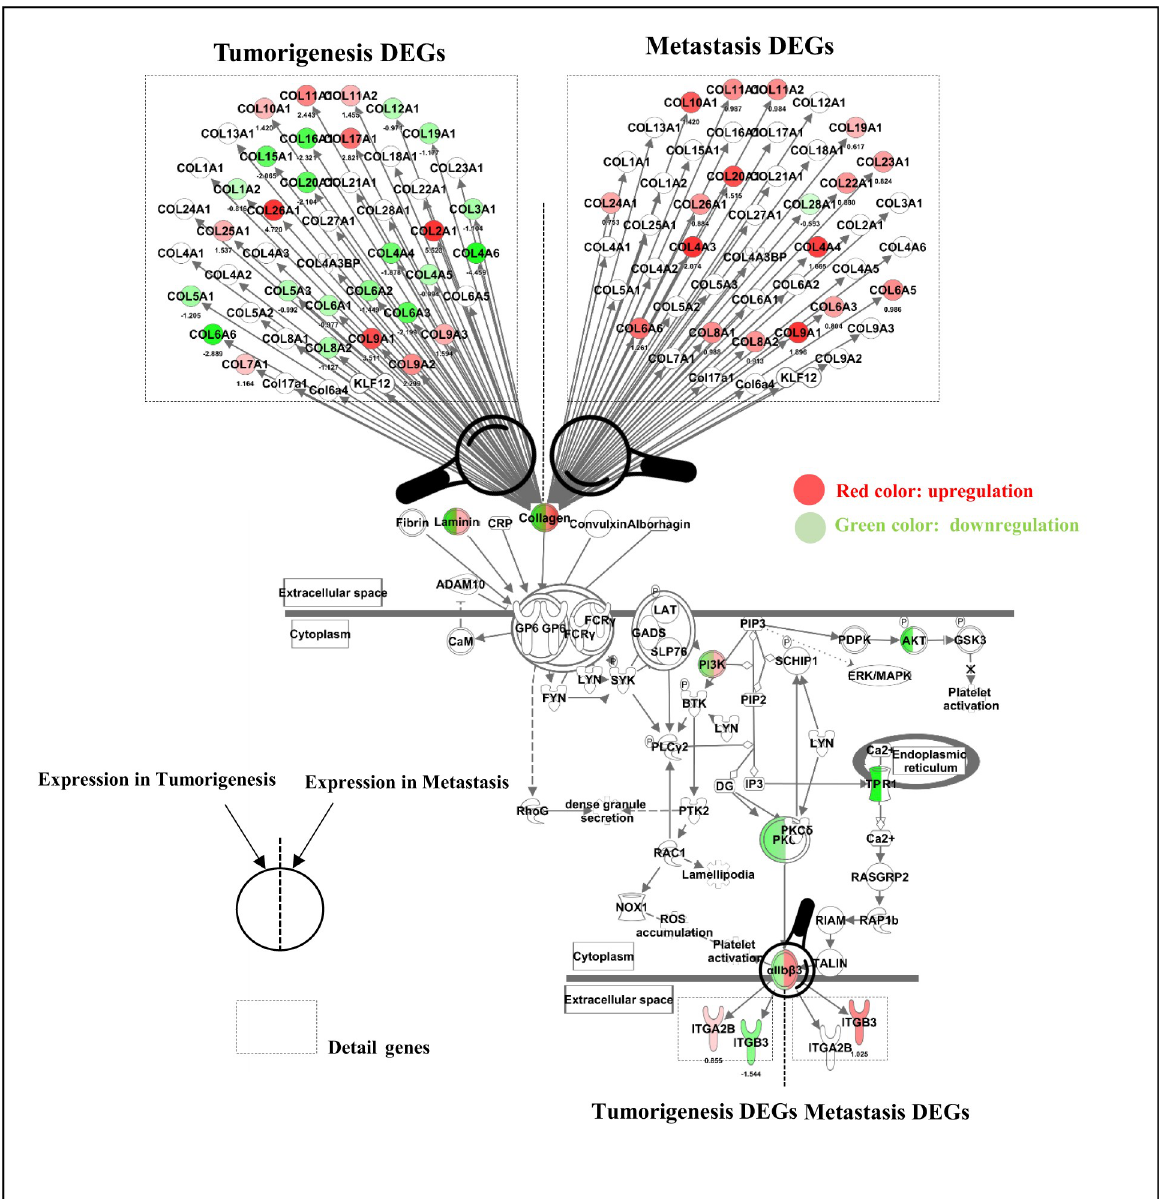
Fig 5. Tumorigenesis- and metastasis-associated PAN-ECM genes and their expressions inGP6 signaling pathway which were generated using QIAGEN’s Ingenuity 1 Pathway Analysis (IPA 1 , QIAGEN Redwood City) Software (27). Typical EC related tumorigenesis- and metastasis-associated PAN-ECM genes were identified. Most of them were collage-related genes and were downregulated in tumorigenesis and upregulated in metastasis of EC. The PAN-ECM genes in volved in GP6 signaling pathway with opposite expression in tumorigenesis and metastasis of EC were colored. Green colour genes indicates an inhibition z-score of -1.414. Red colour genes indicates an activation z-score of 4.146; The color is more intensive, the absolute z-score is higher.